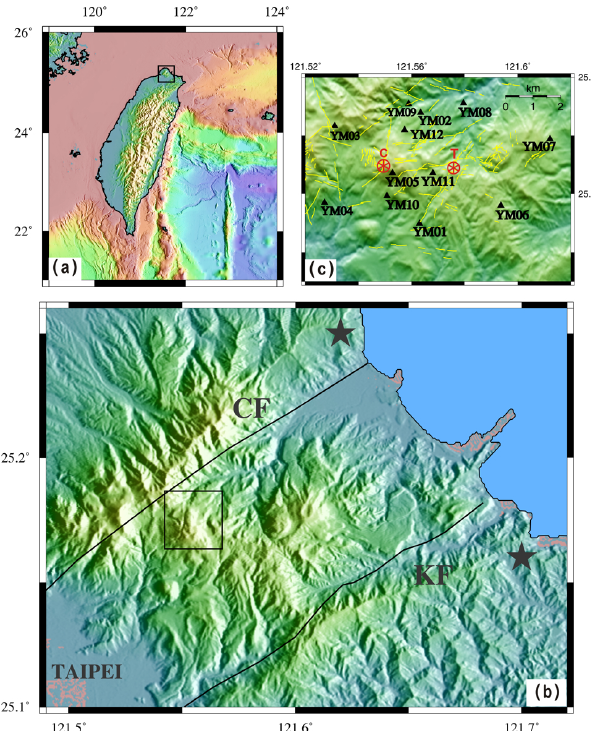
Fig. 1. (a) Map of Taiwan showing the location of Tatun Volcano Group (TVG), (b) map showing the broader Taipei area and the study area of TVG which is highlighted with a square. The thick lines indicate the Kanchiao (KF) and Chinshan Fault (CF) respec- tively while the stars represent the locations of two nuclear power plants, (c) the seismic network distribution used in the study is also presented (YM01-YM12). With C we indicate the location of the Chihsinshan edifice and with T the location of the Tayiokeng area. The yellow lines indicate the fault distribution in the area obtained from LIDAR observations (from Konstantinou et al.,